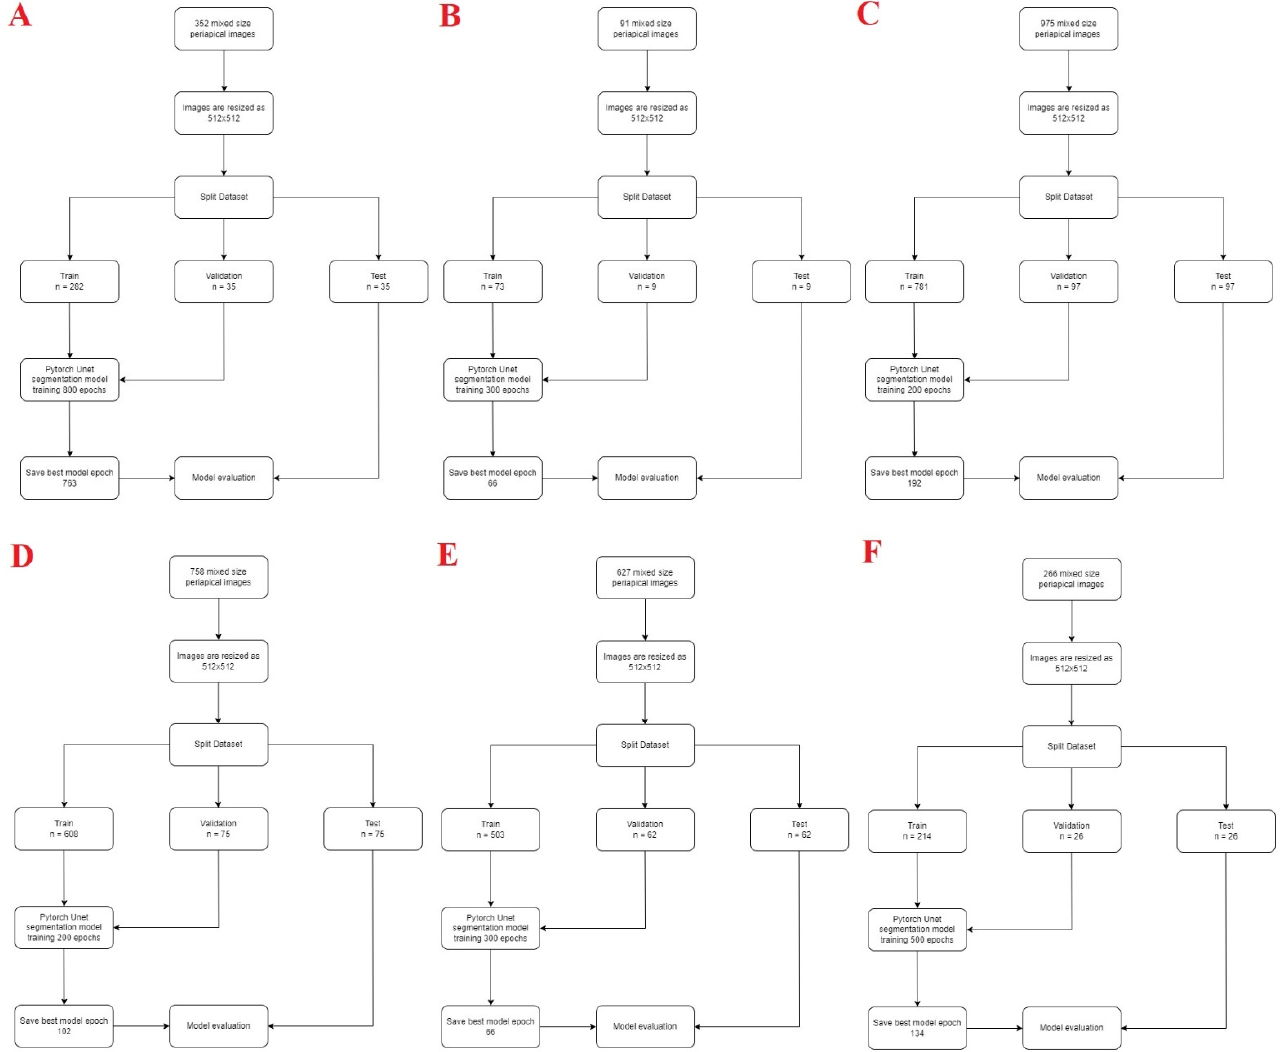
Figure 2. Diagram of the dental conditions’ segmentation model development steps (( A ) carious lesion, ( B ) crown, ( C ) dental pulp, ( D ) filling, ( E ) root canal filling, ( F ) periapical lesion).